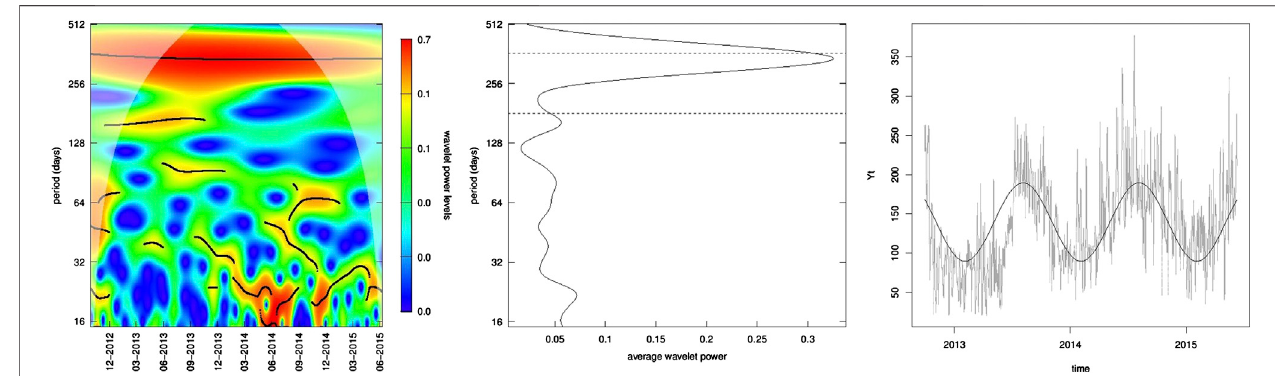
FIGURE2|(Left) Waveletpowerspectrumofdailyradonseriesintime – frequencydomainwiththeCWTmethod.Theblackcontourindicatesthesigni fi cantperiod with 90% con fi dence level. The lighter shade is the regions in fl uenced by edge effects. (Central) The corresponding global power spectrum density marginalizing over time.Thehorizontallinesarefor180-and365-dayperiods. (Right) Thegraylineistheobservedtimeseries,andtheblackcurveisthe fi ttedlinearregressionmodelwith respect to harmonic terms to describe the 1-year periodicity.